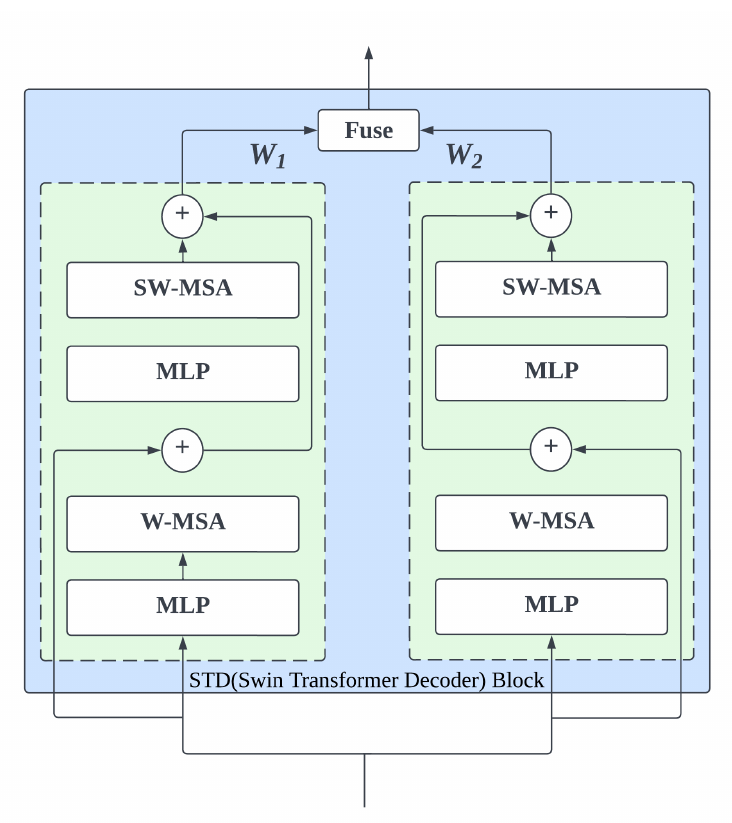
Figure 4. Swin Transformer Decoder (STD)